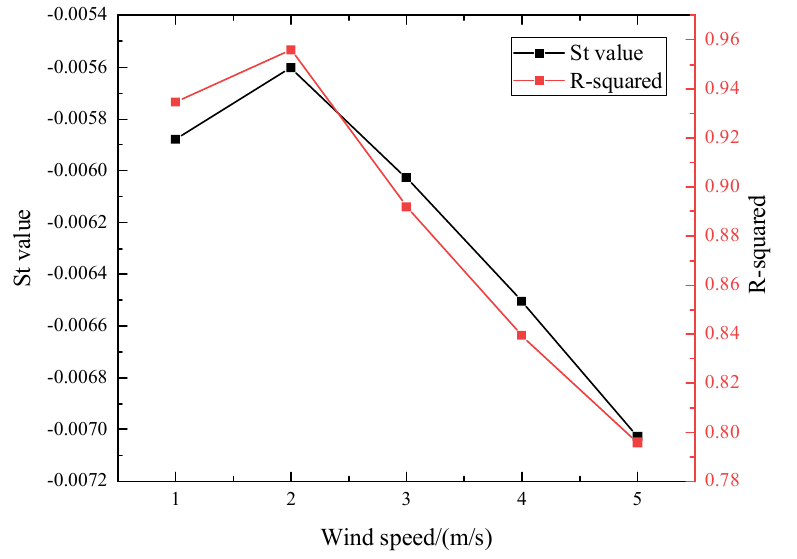
Figure 11. The optimal St value and R square value change diagram under different wind speeds.